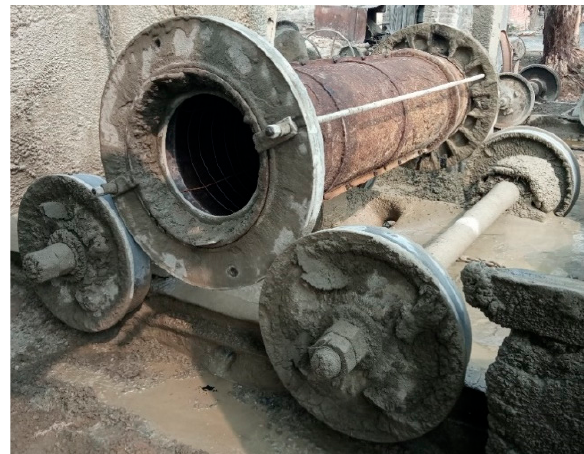
Figure 13. Pipe mold on rotating wheels.